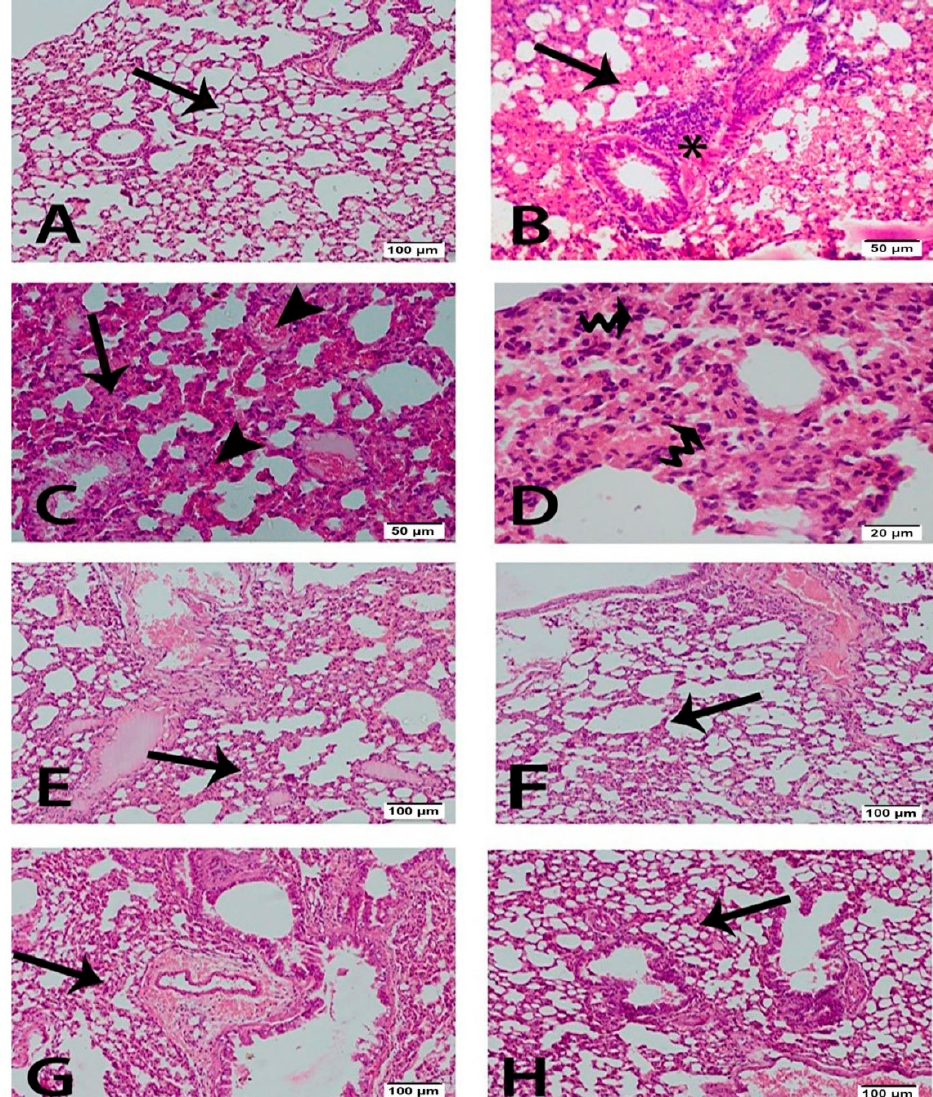
Figure 1. Photomicrographs of the pulmonary sections stained with H&E of different experimental groups. ( A ) Control group showed normal lung tissues with thin interalveolar septa. ( B – D ) CP group showing the inflammatory cell infiltrates, interalveolar thickness, (*) hyperplastic pneumocyte type II and congestion or hemorrhage. ( E ) RKs (25 mg/kg/day) and ( F ) RKs (50 mg/kg/day) treated groups showing reduction of the interalveolar thickness and inflammatory cells. ( G ) RKs (100 mg/kg/day) and ( H ) RKs (200 mg/kg/day) treated groups showing amelioration of lung tissue lesions. Notice the decrease of hyperplastic pneumocyte type II improving of the pulmonary congestion and hemorrhage. ( A , B , E – H ) scale bar 100 μ m ( C ) scale bar 50 μ m ( D ) scale bar 20 μ m.